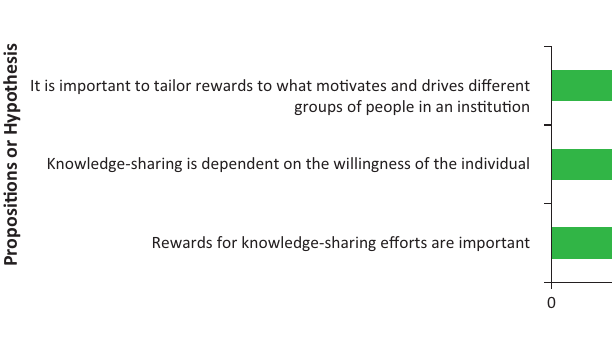
FIGURE 1: Rewards for knowledge-sharing in higher education institutions ( n =